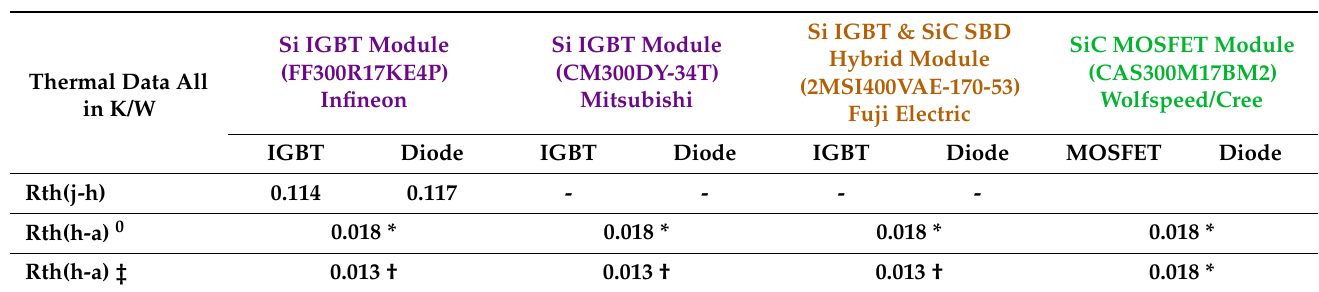
Table A1. Thermal resistances of SiC MOSFET module in comparison with hybrid and Si-IGBT modules and different heatsink sizes. Table A1. Cont.